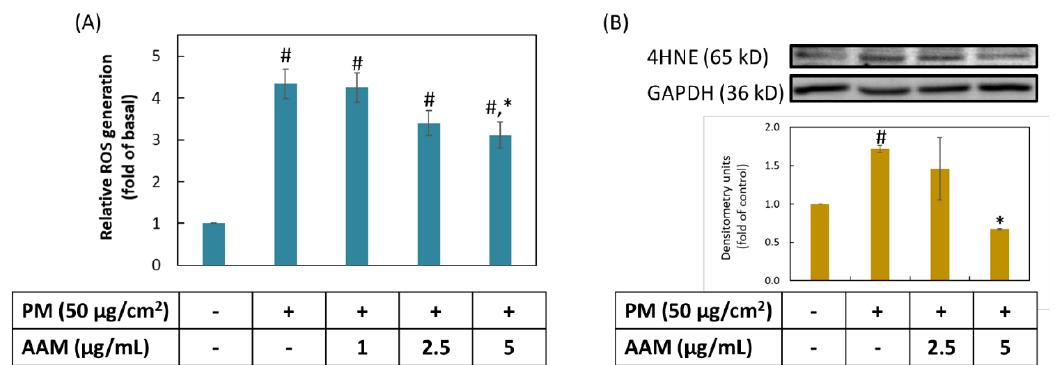
Figure 3. The antioxidant activity of AAM on PM-induced ROS production ( A ) and 4HNE lipid peroxidation ending product ( B ) in HaCaT keratinocytes. Data are shown as the mean ± SD of three independent experiments; # Significantly different from control group ( p < 0.05); * Significantly different from PM treatment alone ( p < 0.05).